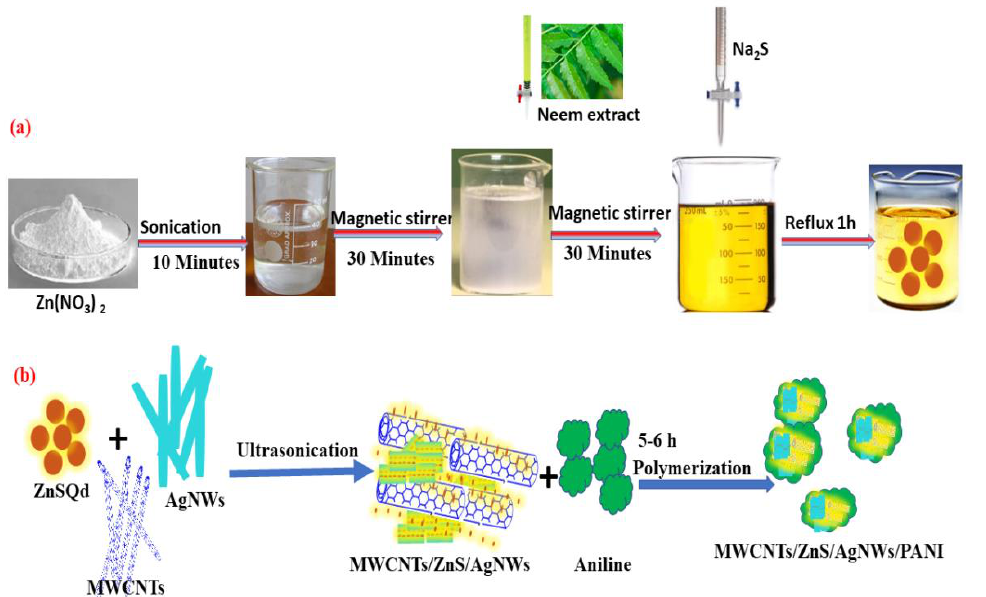
Figure 2. Schematic representation of step-by-step preparation of: ( a ) zinc sulphide quantum dots (ZnS Qds); ( b ) (MWCNT/ZnS/AgNWs/PANI) nanocomposite.